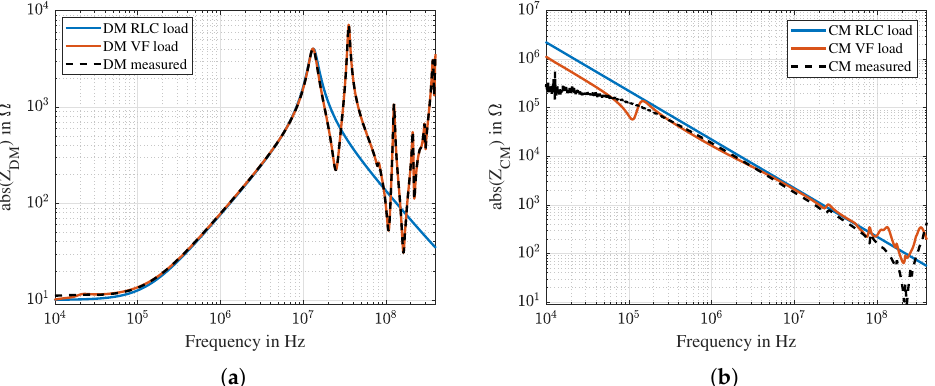
Figure 23. Comparison of the impedance characteristic between RLC load model and VF load model. Respective schematics are displayed in Figure 22. Black dashed lines are the measurement results obtained with the setups from Figure 6. ( a ) DM impedance; ( b ) CM